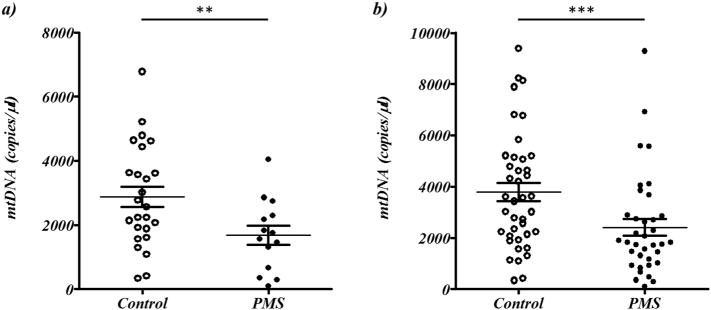
Comparison of ccf-mtDNA copies between PMS cases and controls. The plots depict the comparison of ccf-mtDNA copies (per μl vCSF) between PMS cases (shaded) and matched controls (unshaded): a) with a B2M threshold of <1 copy applied (where mean ccf-mtDNA copies in 14 PMS cases was 1678.0, SEM of 298.4, and 2876.2, SEM of 317.0, in 25 controls) and, b) without a B2M threshold applied (where mean ccf-mtDNA copies in 36 PMS cases was 2412.7, SEM of 327.5, and 3784.7, SEM of 356.4, in 43 controls), where ** and *** indicate Wilcoxon Ranked Sum Test significance at p < .05 and p < .005 respectively.